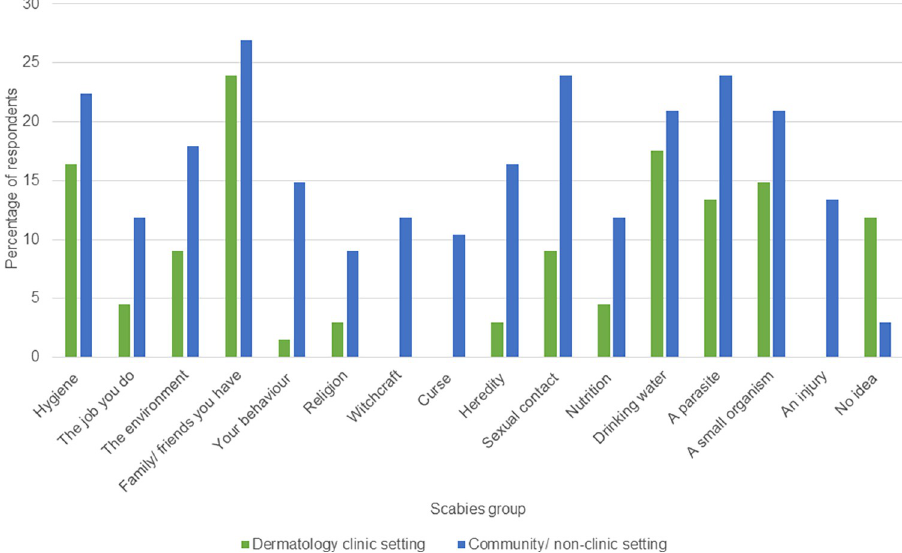
Fig 2. Factors causing scabies in participants in the dermatology clinic versus in the